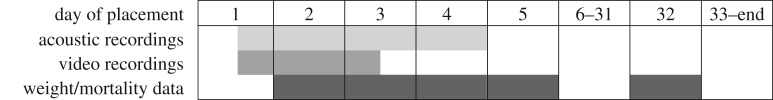
Schematic of acoustic, video and weight/mortality data collection days per flock.